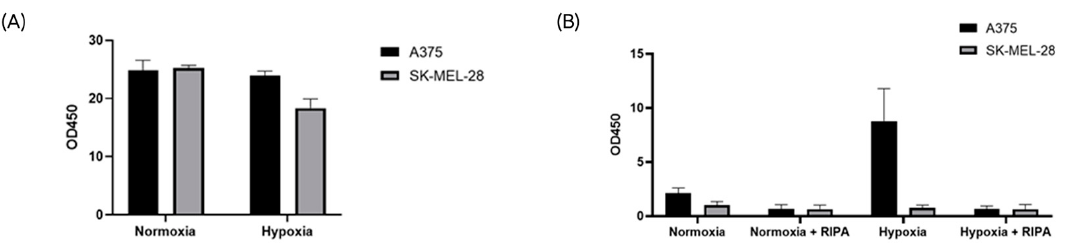
Figure 5. The CA-IX protein is associated with the membrane of hypoxic sEVs. EV identity was con fi rmed for all samples with the CD9 ELISA assay ( A ). Only A375 cells released CAIX-positive confirmed for all samples with the CD9 ELISA assay ( A ). Only A375 cells released sEVs under hypoxia, and the CAI-X protein was associated with the EV membrane ( B ).